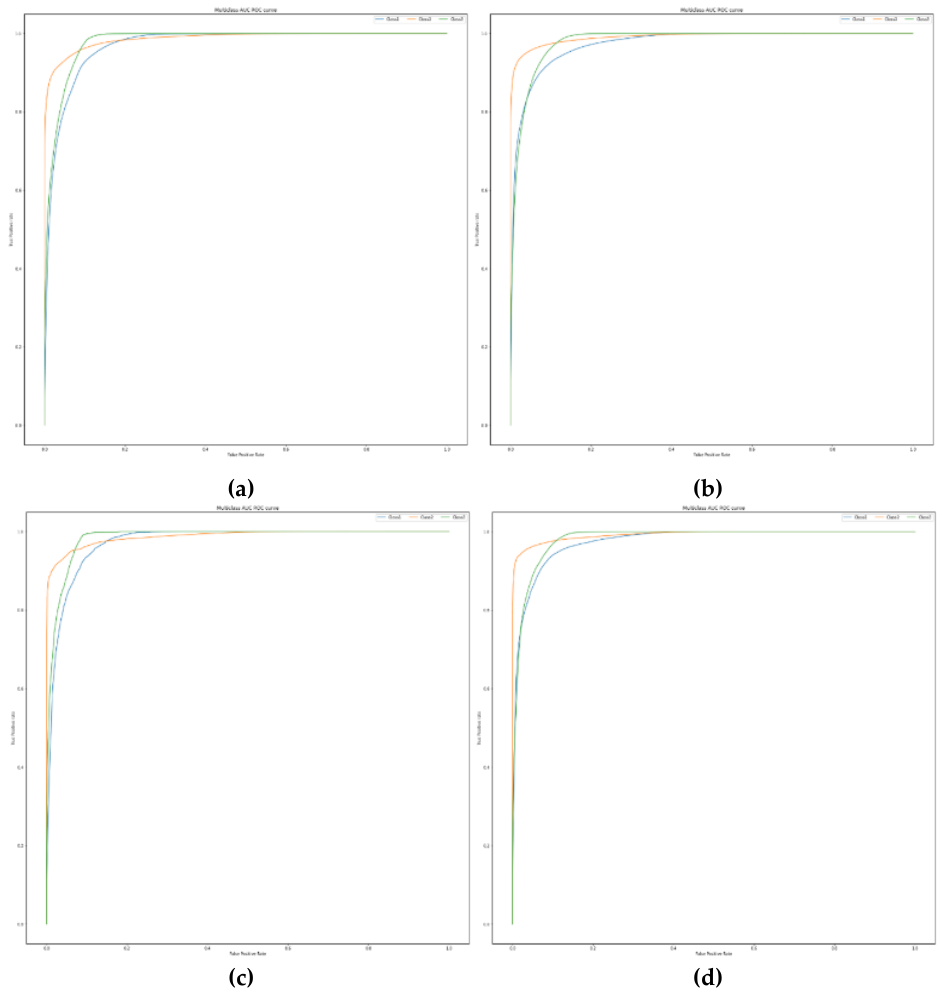
Figure 11. The AUC-ROC curves for the Deep Learning algorithms, listed as: (a) DNN in setting 1; (b) DNN in setting 2; (c) LSTM in setting 1; (d) LSTM in setting 2.